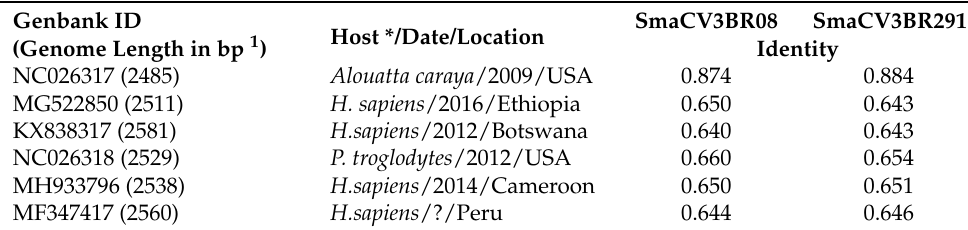
Table 1. Nucleotide identity of complete genomes of members of